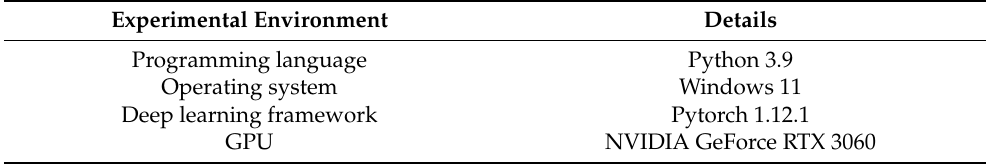
Table 1. Experimental conditions.